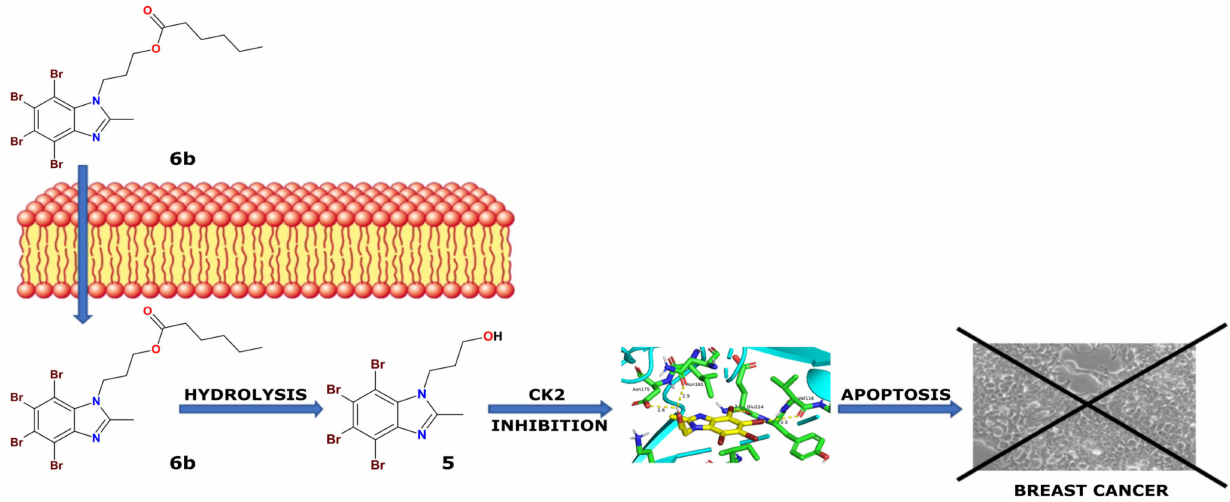
Figure 10. Hypothetical mechanism of action of the designed prodrug-like ester 6b on breast cancer cells that, after entering the cell, is hydrolyzed to the active form of CK2 inhibitor 5